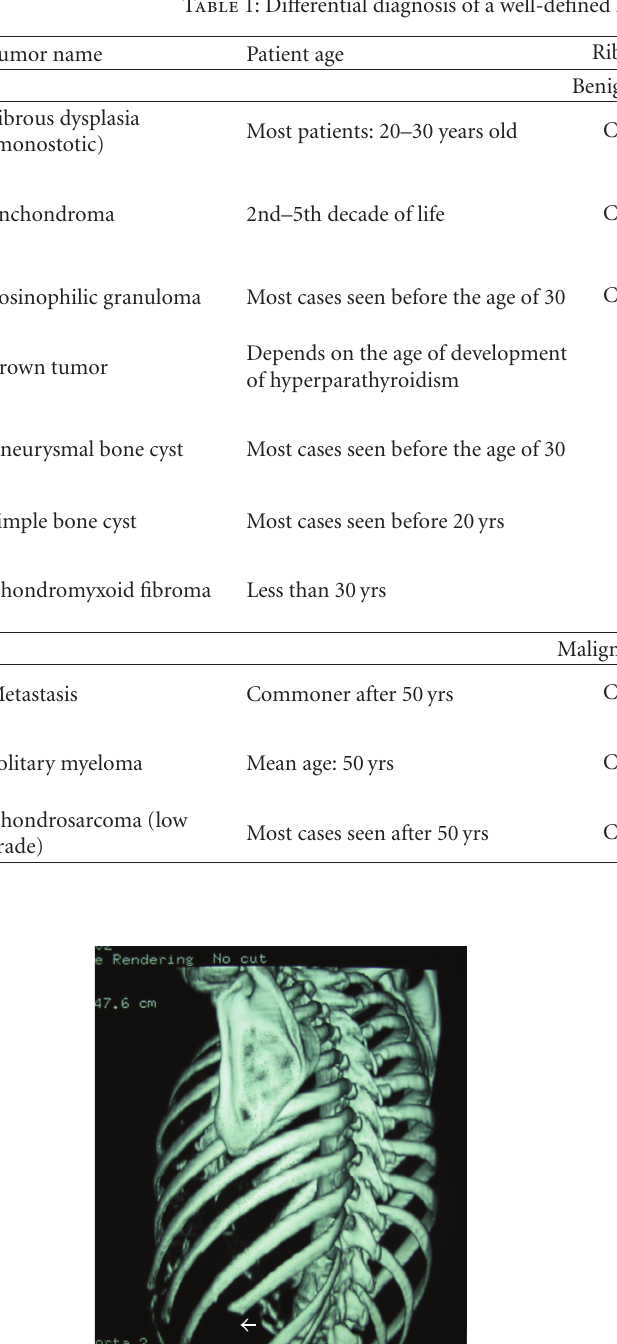
Table 1: Di ff erential diagnosis of a well-defined lytic lesion of the rib (based on [3, 9, 12, 13]).